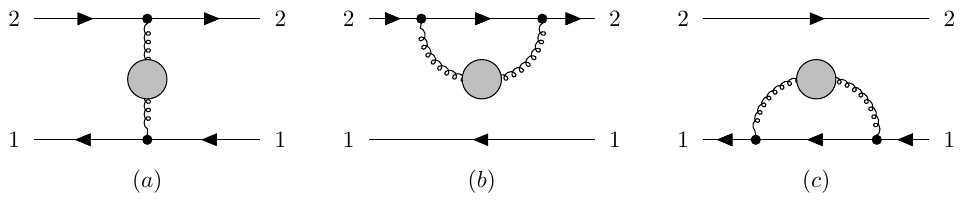
Figure 1 . The “cross” contribution (a), and the two self-energy contributions (b) and (c). In these figures, time flows from the right to the left. To emphasize the HTL contribution in the gluon propagator, we put the blobs in these